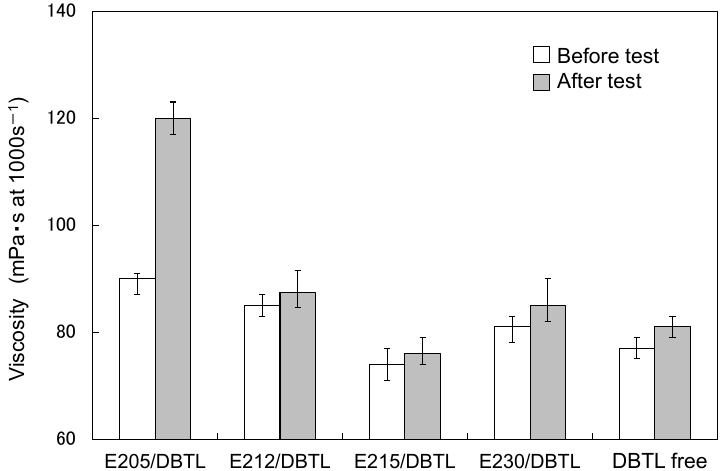
Figure 6. Storage stability of the waterborne paint with dibutyl tin dilaurate (DBTL) encapsulated in a micelle.